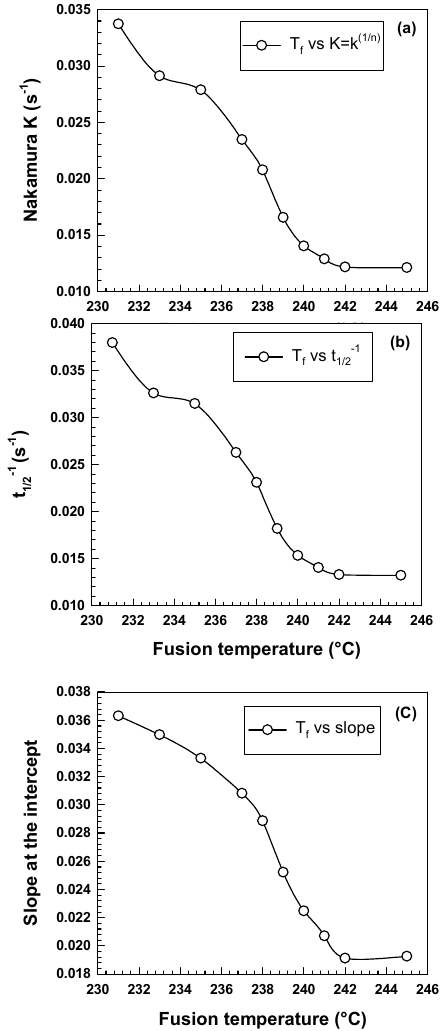
Figure 6. In fl uence of fusion temperature on the kinetics parameters ( a ) Nakamura K , ( b ) t 1/2 − 1 , ( c ) slope at the intercept.